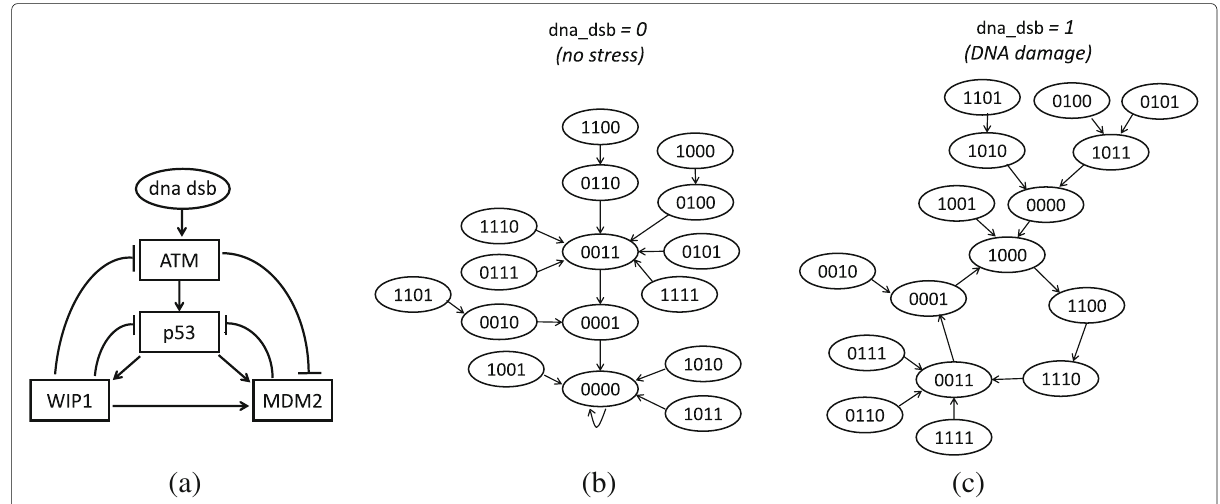
Fig. 4 a – c Activation/repression pathway diagram and state transition diagrams corresponding to a constant input dna_dsb = 0 (no-stress) and dna_dsb = 1 (DNA-damage) for the P53-MDM2 negative-feedback loop Boolean network model with negative regulation biases